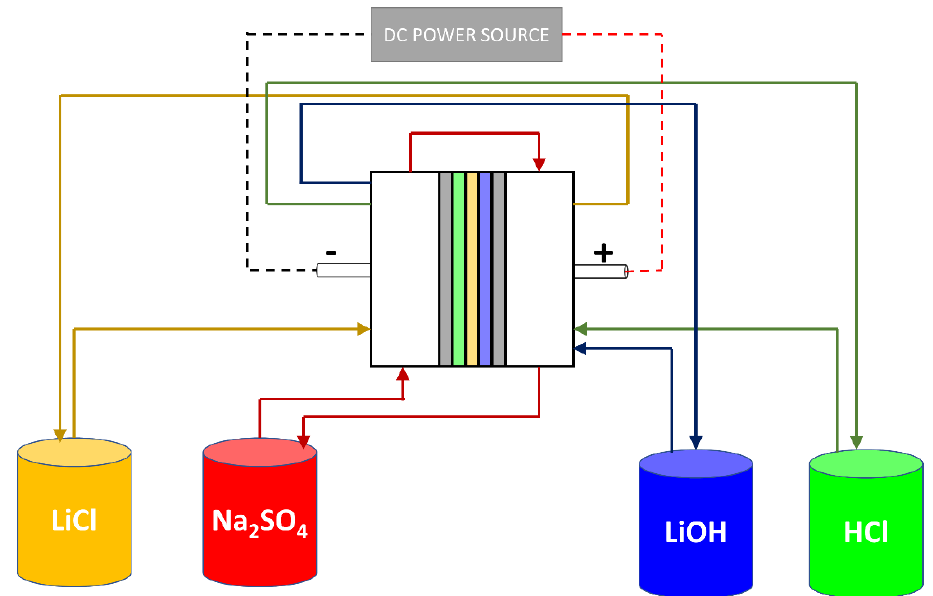
Figure 4. LiOH production system by BMED.